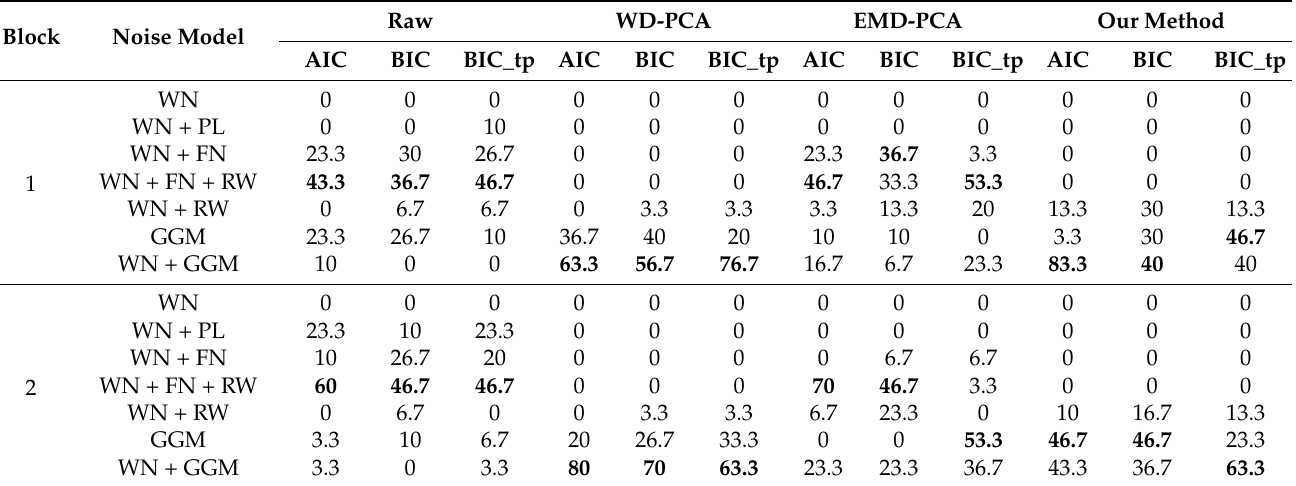
Table 6. Percentage of each noise model with the lowest values of the Akaike information criterion (AIC), Bayesian information criterion (BIC) and BIC_tp of the raw and denoised GNSS residual sequences at Blocks 1 and 2 (the value in bold indicates the optimal noise model